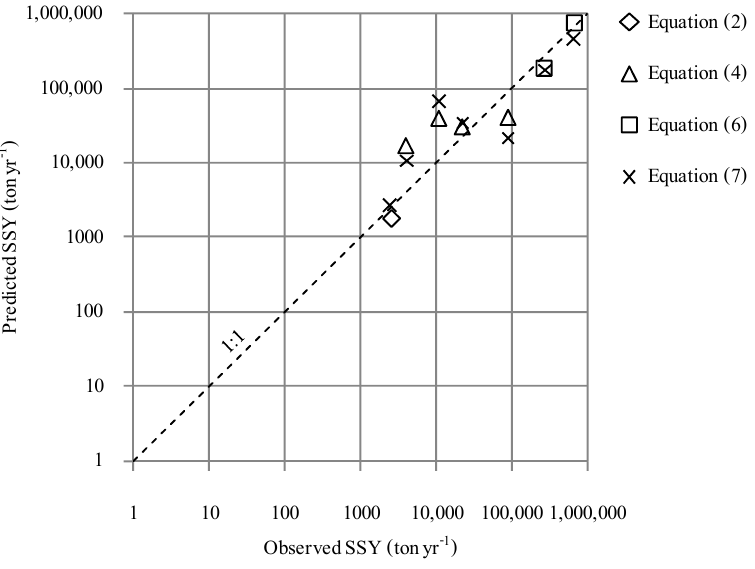
Figure 4. Validation results for SSY